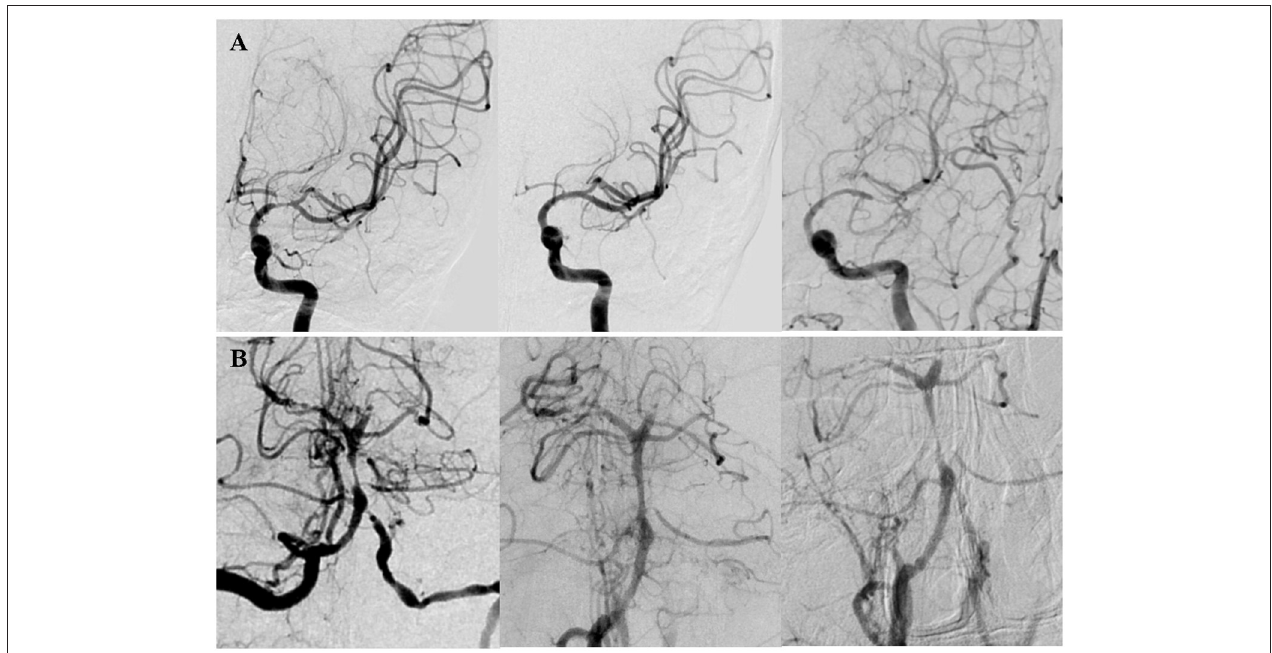
FIGURE 1 | Two patients with in-stent restenosis (ISR) by DSA. (A) A patient presented with right limb weakness and numbness for 10 months due to severe stenosis (70%) at the M1 segment of the left MCA. The Mori classification was type C. The lesion was dilated with a 2.25 × 9mm Gateway balloon (Boston Scientific, Fremont, CA) and implanted a 4 × 23mm Enterprise stent (Codman Neurovascular, Raynham, Mass). Postoperative DSA showed the degree of stenosis decreased to 5%. DSA after 17 months of the procedure showed significant in-stent restenosis (ISR). (B) A patient presented with bilateral lower limbs weakness and diplopia for 2 months due to high-grade stenosis (80%) at the middle segment of the BA. The lesion was dilated with a 2 × 9mm Gateway balloon and implanted a 4.5 × 14mm Enterprise stent. Postoperative DSA showed the degree of stenosis decreased to 35%. DSA after 6.33 months of the procedure showed significant